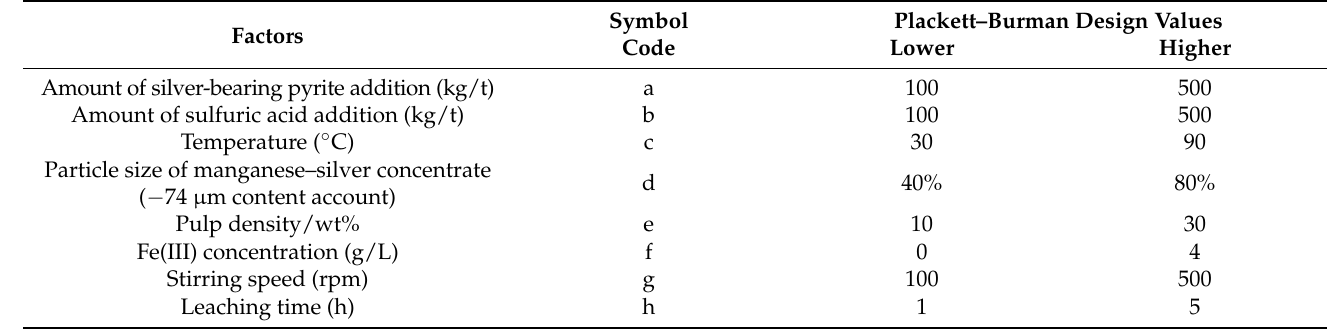
Table 2. Experimental parameters in two levels designed by Plackett–Burman design model.